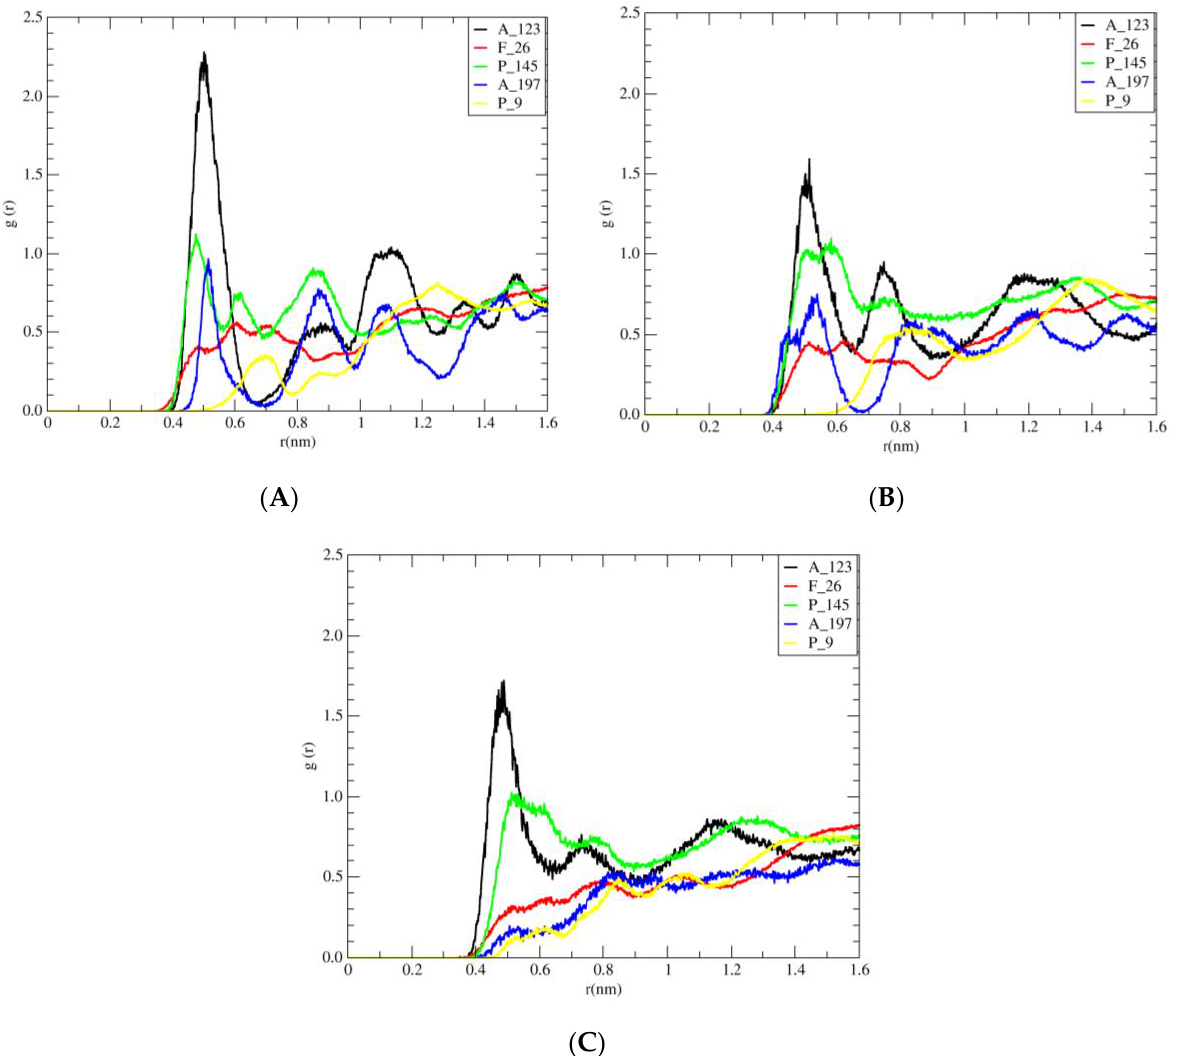
Figure 10. Radial distribution functions (RDFs) for atoms with ( A ) side chain of amino acids A_123 (in black), F_26 (in red), P_145 (in green), A_197 (in blue), and P_9 (in yellow) of the hydrophobic surface and nitrogen of cholinium cations in 40% of [Ch] 3 [PO 4 ]. ( B ) Side chain of amino acids A_123, F_26, P_145, A_197, and P_9 of the hydrophobic surface and nitrogen of cholinium cations in 30% of [Ch] 3 [PO 4 ]. ( C ) Side chain of amino acids A_123, F_26, P_145, A_197, and P_9 of the hydrophobic surface and nitrogen of cholinium cations in 20% of [Ch] 3 [PO 4 ].